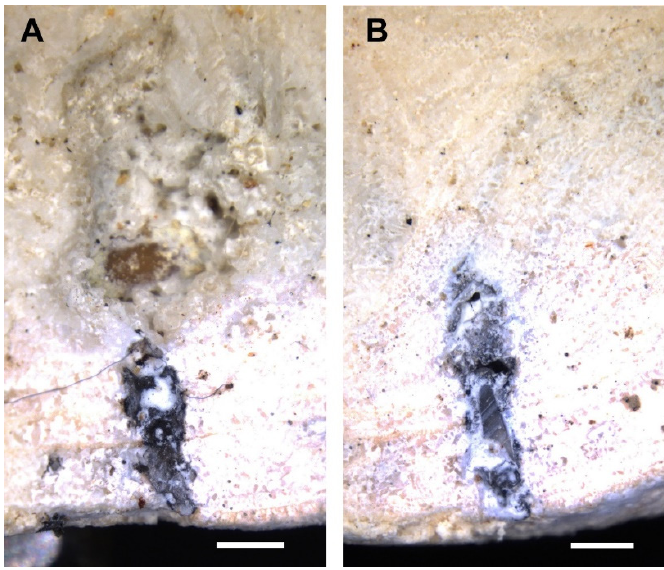
Figure 3. The longitudinal section of a hole melted in a stone by laser at 0.97 μ m wavelength in air after 2 s ( A ) and 5 s ( B ). Scale bar is 1 mm.